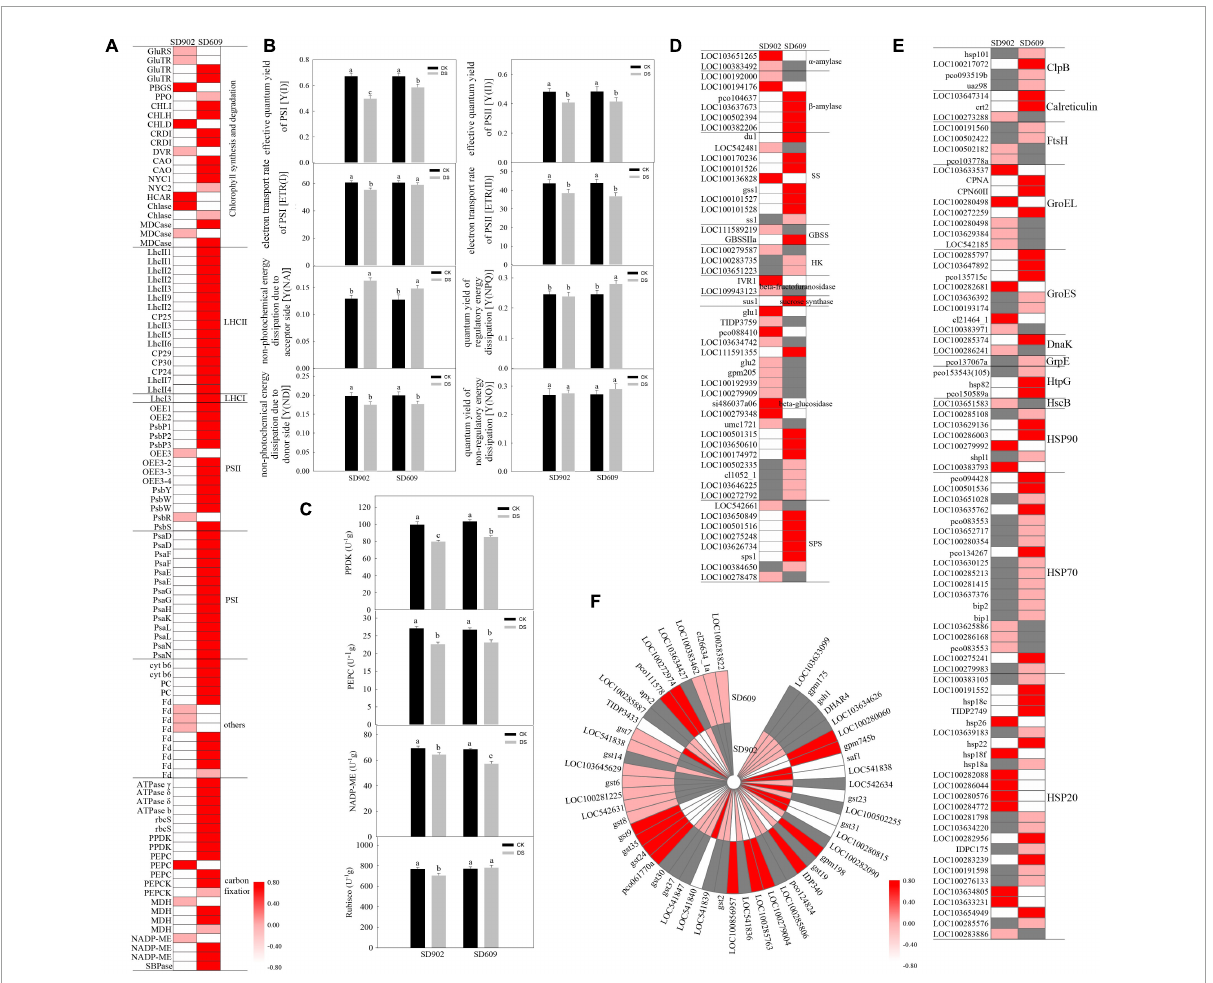
FIGURE4 Responses of photosynthesis, energy conversion, protein protection, and AsA-GSH cycle between SD902 and SD609 under drought stress. (A) Expression profile of transcripts involved in photosynthesis. (B) Fluorescence parameters of PSII and PSd between the two genotypes by measuring photosynthetic efficiency. (C) Activity levels of key enzymes involved in carbon assimilation by ELISA analysis. (D–F) Expression profile of transcripts involved in energy conversion, protein protection, and AsA-GSH cycle. The heatmap is summarized by log2 (FC) of each gene from RNA-seq data. The data shown are the means of three replicates ( ± SD). Means denoted with the same letter did not significantly differ at P < 0.05. Y(I), effective quantum yield of PSI; Y(II), effective quantum yield of PSII; ETR(I), electron transport rate of PSI; ETR(II), electron transport rate of PSII; Y(NA), quantum yield of non-photochemical energy dissipation due to the acceptor side; Y(ND), quantum yield of non-photochemical energy dissipation due to PSI donor side; Y(NPQ), quantum yield of regulatory energy dissipation of PSII; Y(NO), quantum yield of non-regulatory energy dissipation of PSII; PEPC, phosphoenolpyruvate carboxylase; Rubisco, ribulose-bisphosphate carboxylase small chains; PPDK, pyruvate orthophosphate dikinases; NADP-ME, NADP-malate dehydrogenases; DS, drought stress treatment; CK,